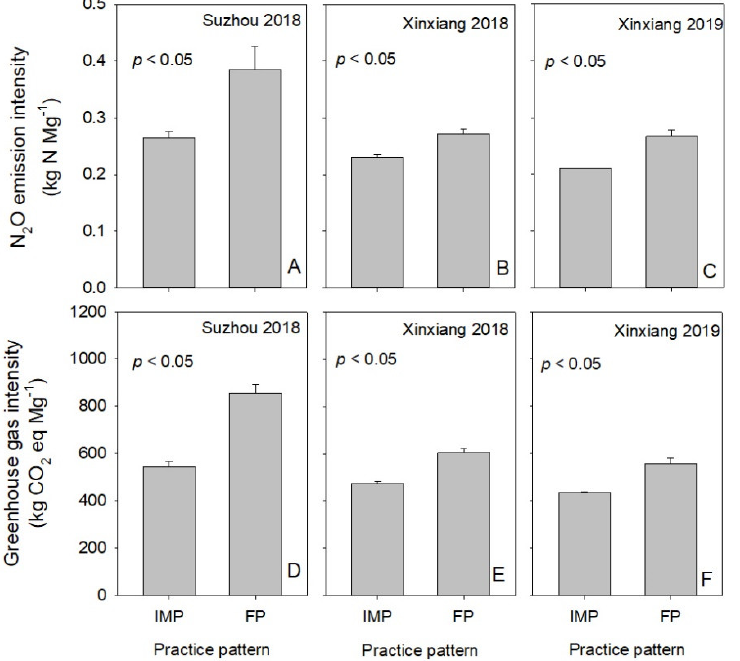
Figure 8. The effects of seeding management practices on N 2 O emission intensity and greenhouse gas intensity of soybean production. IMP, integrated management practice; FP, farmers’ practice. The bottom and top bars of each dataset represent standard error. ( A ) represents the N 2 O emission intensity at Suzhou site in 2018. ( B , C ) represent the N 2 O emission intensity at Xinxiang site in 2018 and 2019, respectively. ( D ) represents the greenhouse gas intensity at Suzhou site in 2018. ( E , F ) represent the greenhouse gas intensity at Xinxiang site in 2018 and 2019,